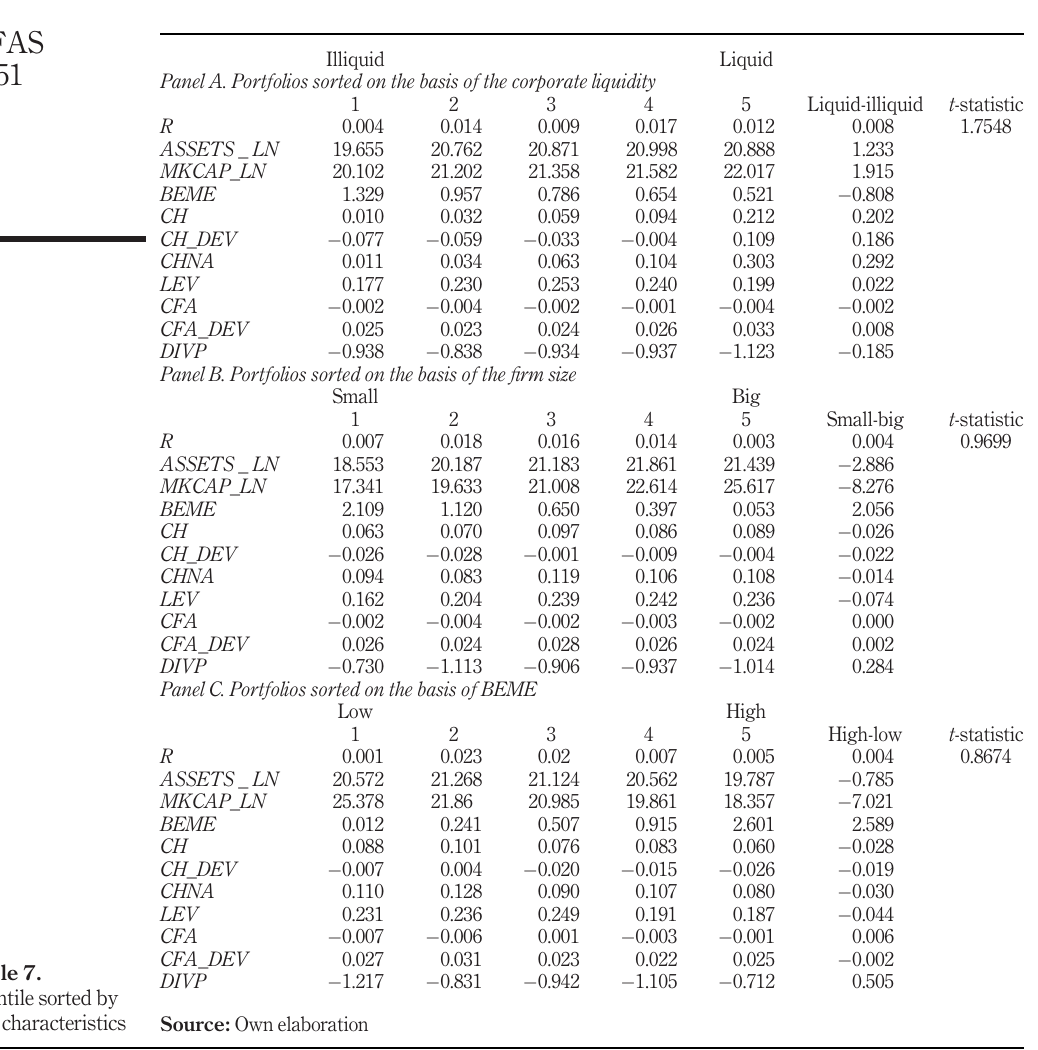
Table 7. Quantile sorted by fi rm